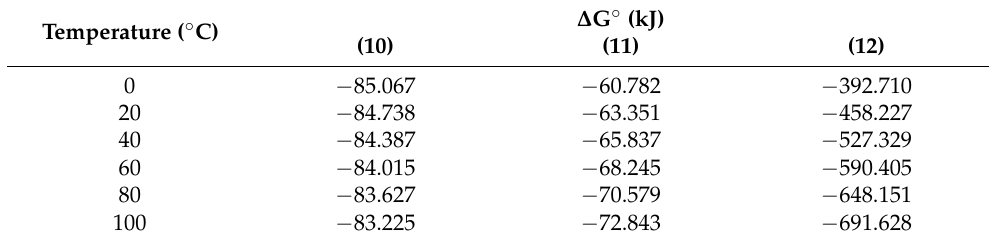
Table 8. ∆ G ◦ values of CAF dust precipitation by Na 2 CO 3 at temperatures from 0 to 100 ◦ C.